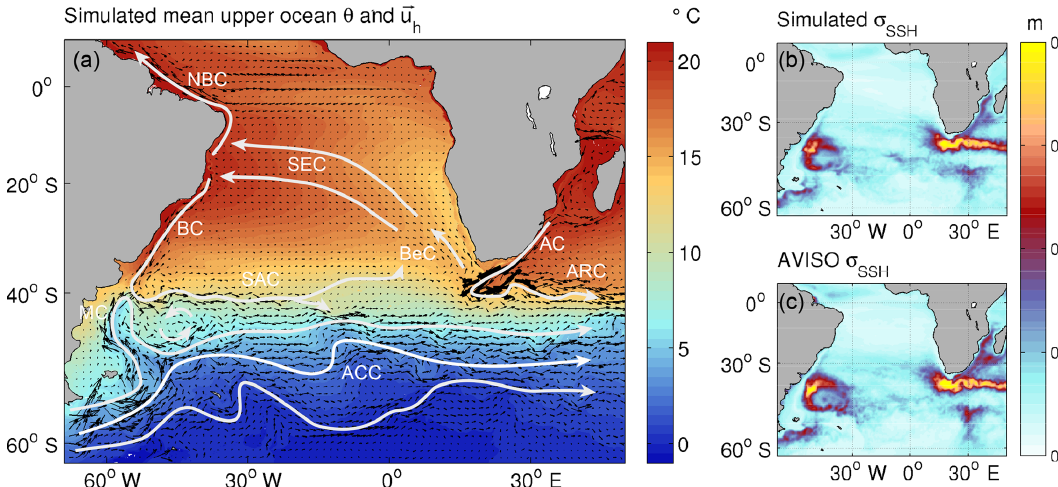
Figure 1. South Atlantic circulation pattern. (a) Simulated mean (2000–2009) upper ocean (averaged over upper 750m of depth) potential temperature θ (color shading) and horizontal velocity u h (vectors); velocity components have been averaged onto a 1 . 5 ◦ × 1 . 5 ◦ grid for plotting purposes; white arrows highlight major currents of interest for this study: Agulhas Current (AC), Agulhas Return Current (ARC), Benguela Current (BeC), Antarctic Circumpolar Current (ACC), Malvinas Current (MC), South Atlantic Current (SAC), South Equatorial Current (SEC), North Brazil Current (NBC), and Brazil Current (BC). (b–c) Mean standard deviation of sea surface height σ SSH from simulations and AVISO based on 5d means in 2000–2009.